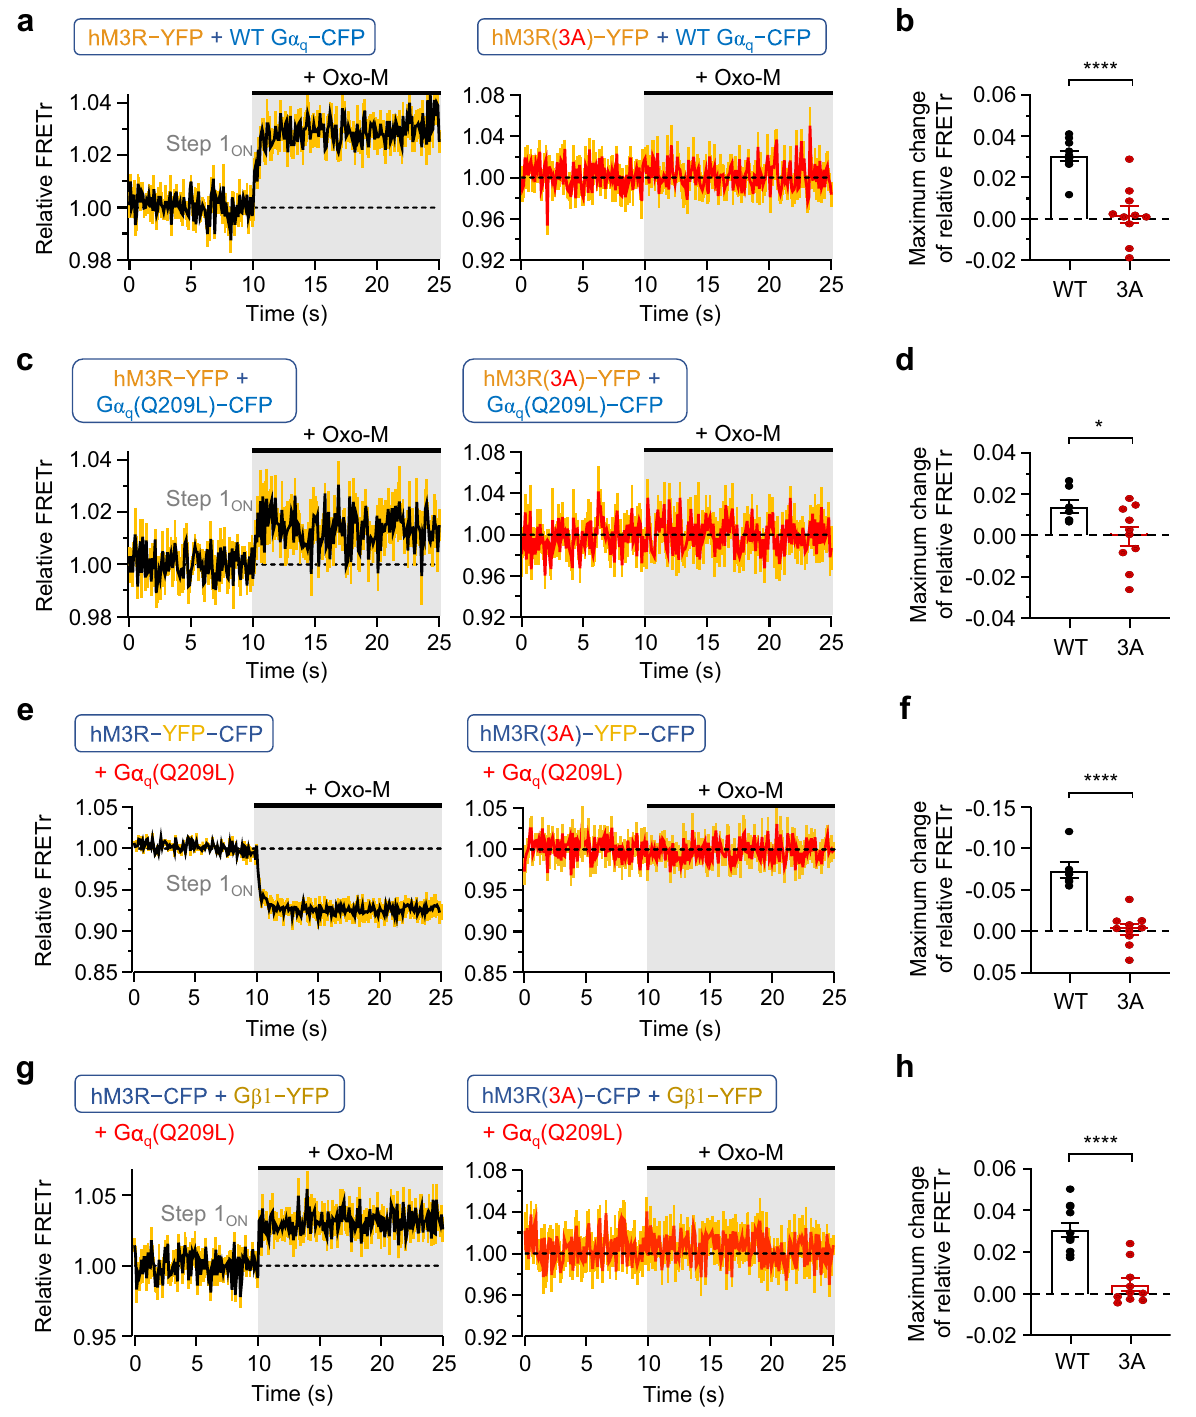
Fig. 6 | hM3R(3A) does not interact with G βγ subunits independently. a